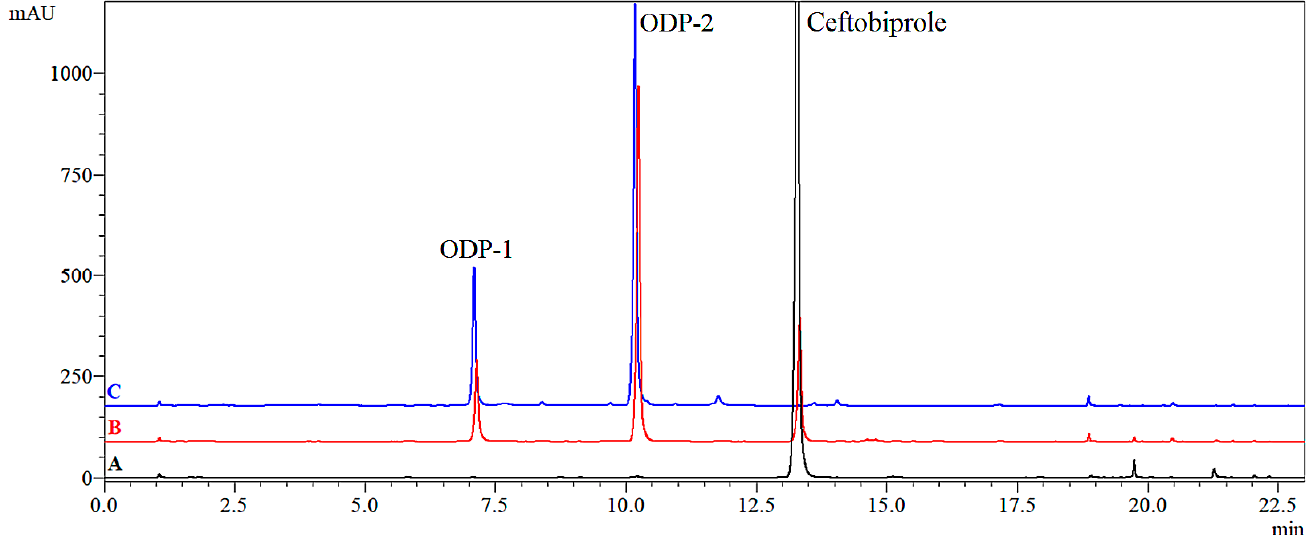
Figure 7. Overlaid chromatograms obtained from the separation of a 1 mg/mL ceftobiprole solution by oxidation with 3% H 2 O 2 : ( A ) ceftobiprole in 10% DMSO at time 0; ( B ) in 10% DMSO after 1080 min (18 h); ( C ) in 0.1 M HCl after 1080 min.